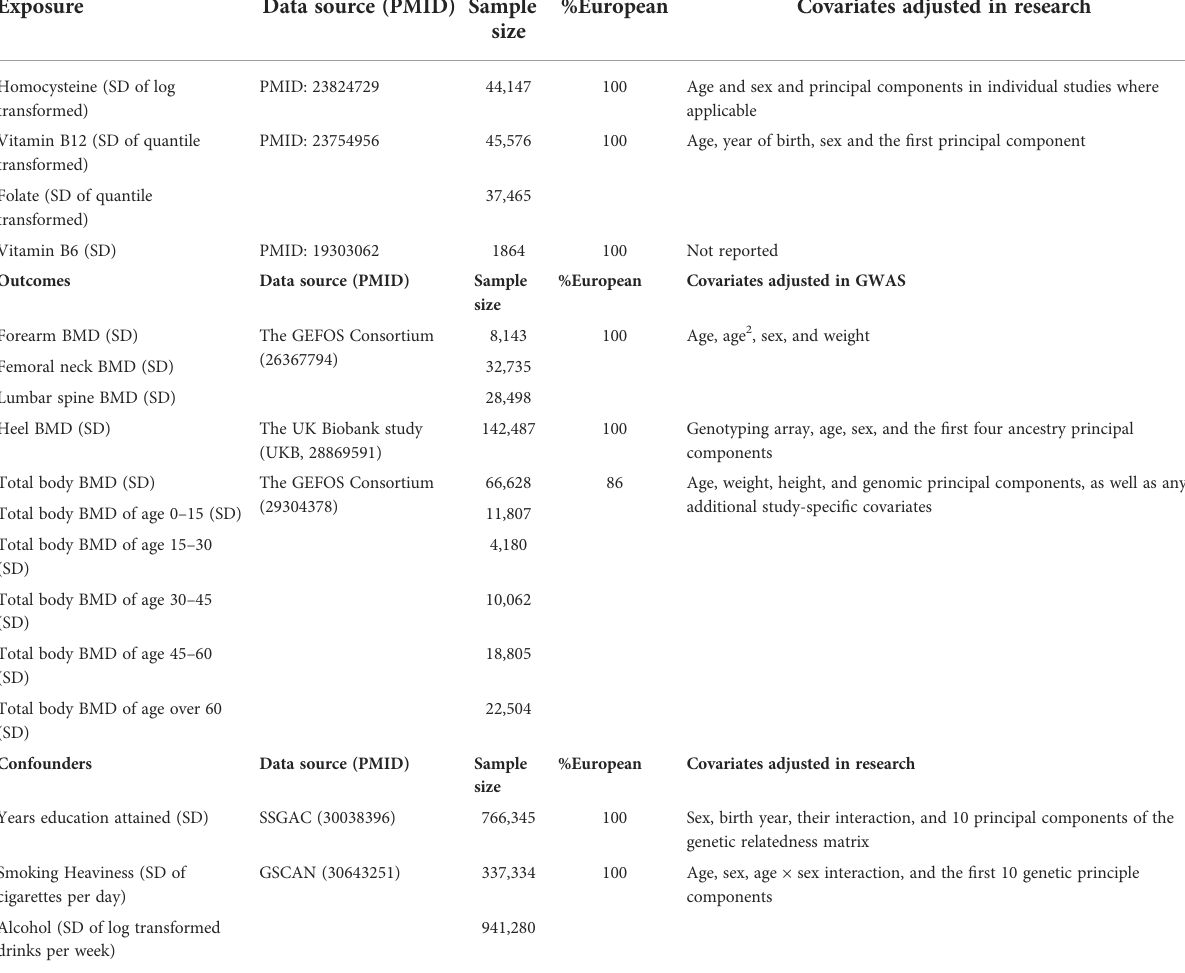
TABLE 1 Descriptions of the genome-wide association studies (GWASs) employed in this Mendelian randomization study.